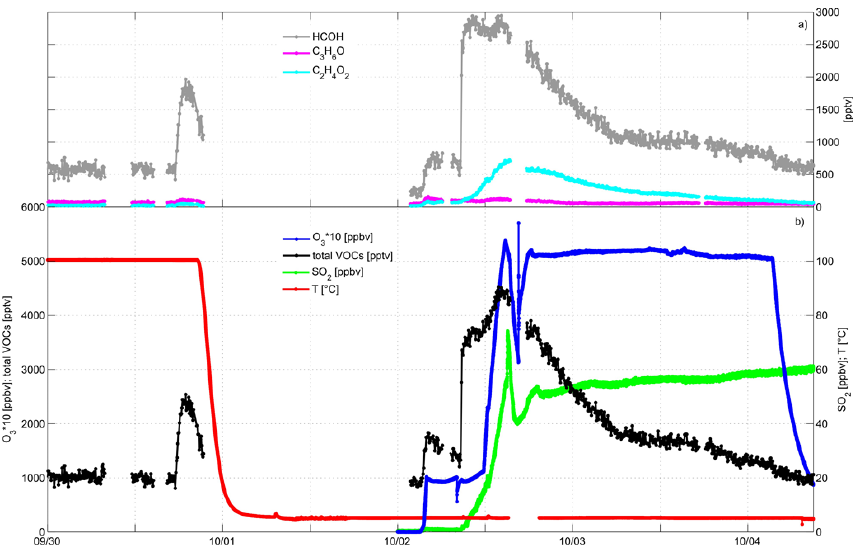
Figure 7. Total (b) and individual VOCs (a) at the beginning of CLOUD7, when following a heating cycle, ozone and SO 2 were sequentially added to the